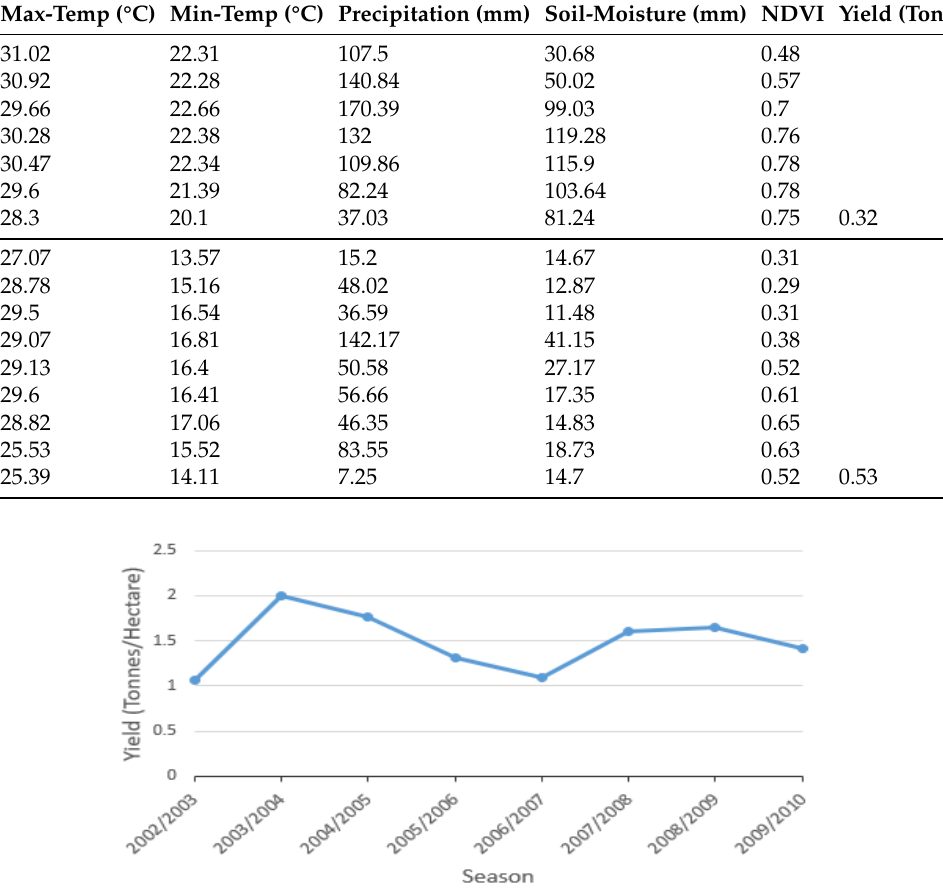
Figure 6. Mufindi district maize yields from 2002/2003 to 2009/2010